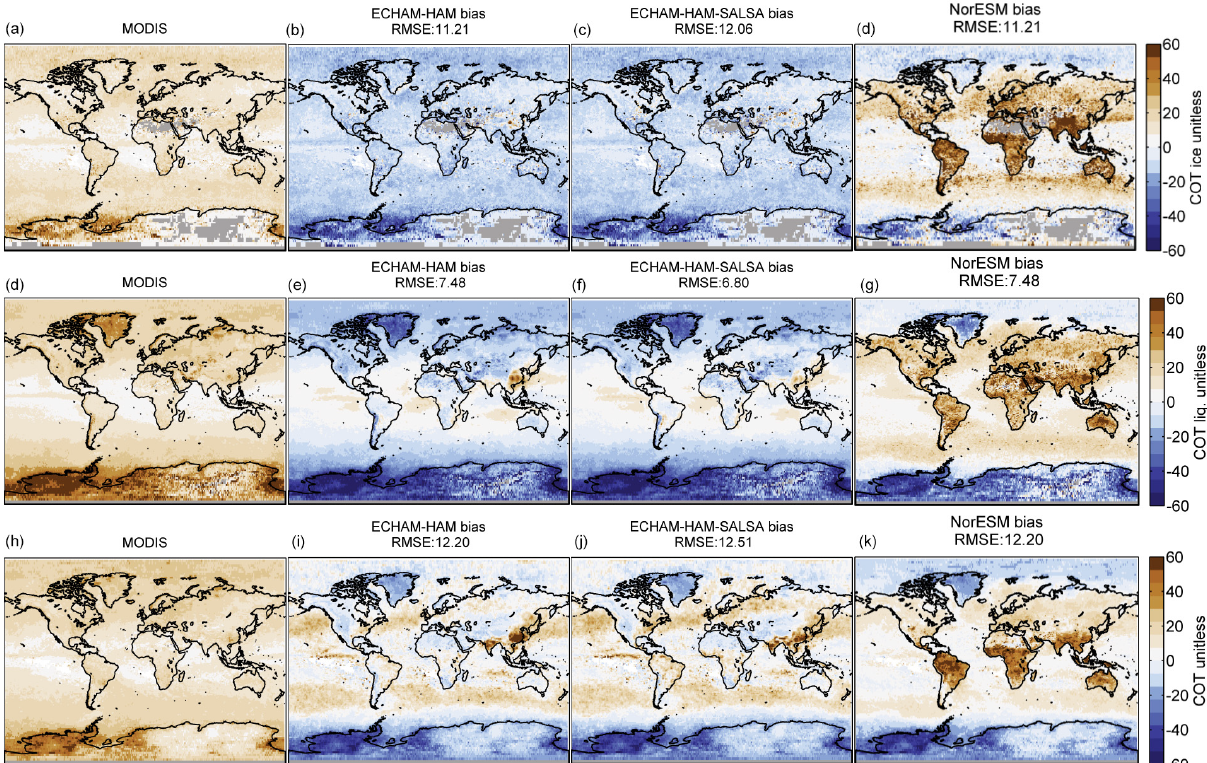
Figure 3. Annual global mean bias in cloud optical thickness for ice clouds (b–d) , liquid water clouds (e–g) , and total (combined ice and water clouds) COT (i–k) between MODIS and ECHAM-HAM, ECHAM-HAM-SALSA, and NorESM. The bias represents the difference between MODIS-COSP diagnostics and MODIS observations. Pixels with liquid cloud fraction ≤ 30% are screened. The averages represent in-cloud values. High latitudes (lat > 60 ◦ N or lat > 60 ◦ S) are excluded in the computation of the root mean square error (RMSE). MODIS spatial distribution is presented as reference (a, d, h)